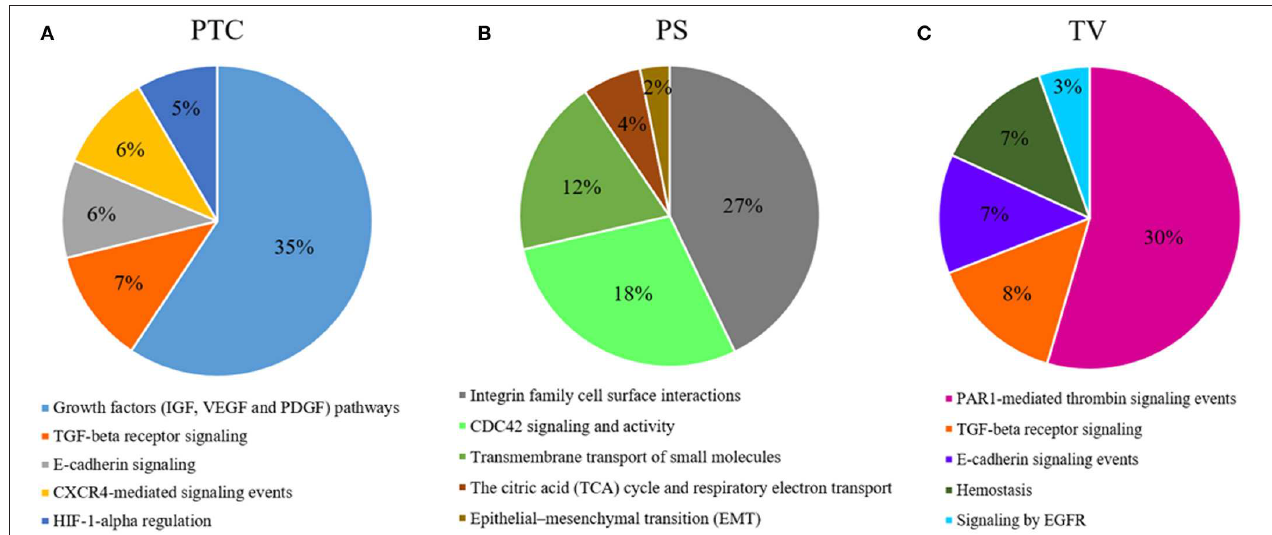
FIGURE 5 | Functional enrichment analysis of DEGs. Top 5 biological processes up-regulated with percentage of DEGs involved in a specific pathway in (A) , PTC to pseudopalisading astrocytes and, (B) PS perineuronal astrocytes comparing to TC tumor core astrocytes and, (C) TV tumor blood vessels comparing to normal blood vessels.